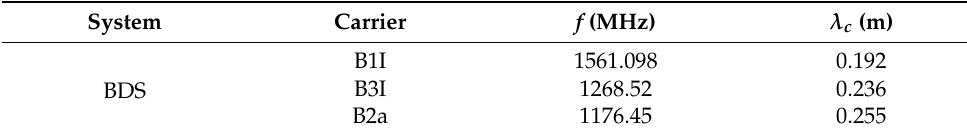
Table 1. Information of the triple-frequency